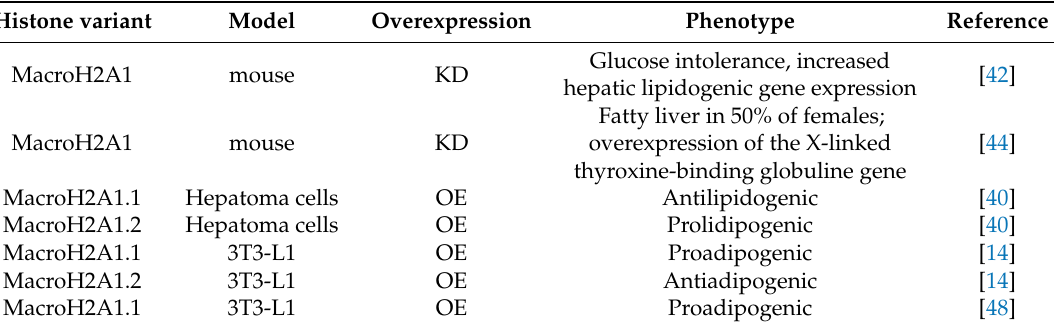
Table 2. Effects of manipulating histone variants expression on lipid